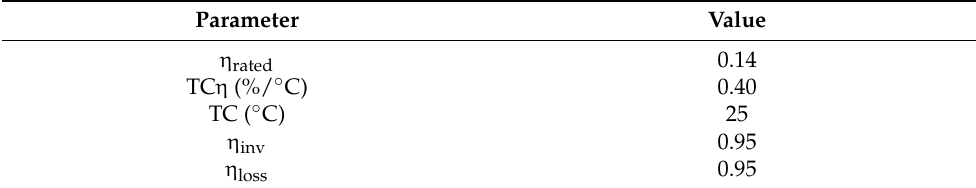
Table 6. Typical PV and equipment parameters.